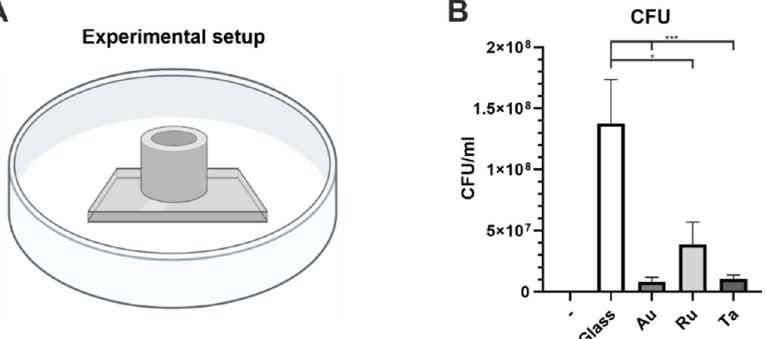
Figure 6. Colony Forming unit assay of Pseudomonas aeruginosa on different metal coatings and uncoated glass as control. On the left side a scheme of the experimental setup is depicted, showing a cloning cylinder on a glass slide in a Petri dish ( A ). This setup was used to ensure that the bacterial growth occurs only on the coated surface and in a defined area. On the right side a graph of the CFU assay per ml is presented ( B ). The first bar (-) is a result of a sterility control with glass incubated in LB medium only. Note that no colonies grow. Uncoated glass shows highly efficient bacterial growth (white-colored bar). Gold coating vastly reduced bacterial growth (medium gray bar). Ru- thenium coating showed less antibacterial potential (light gray bar). Tantalum coating reduced bac- terial growth nearly as efficiently as gold. Scheme in ( A ) was created with BioRender.com (accessed on 10 September 2022). Definition of statistical significance: p < 0.05 (*), p < 0.01 (**), p < 0.001 (***), p < 0.0001 (****).